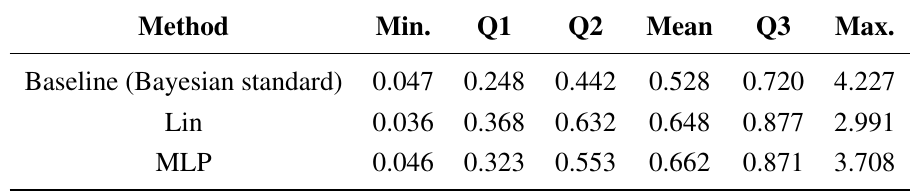
Table 1. Comparison between Bayesian baseline and ANNs models. Both methods has a p = 8 inputs and q = 8 outputs. The MLP has a hidden layer with h = 8 neurons.